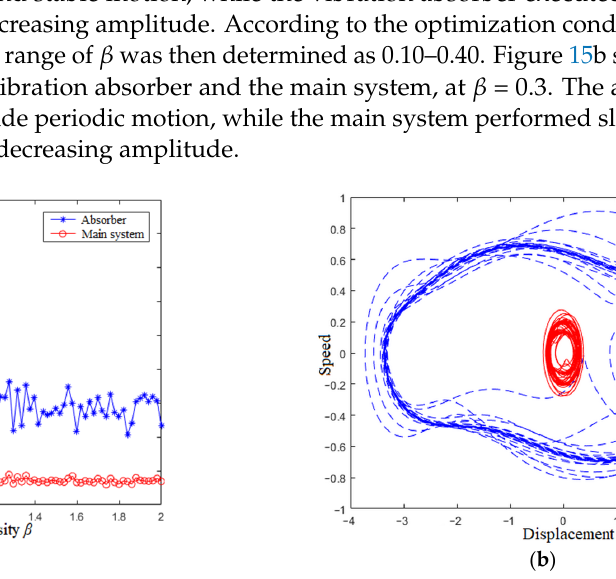
Figure 15. Response amplitude and phase diagram of two vibrators in the case of off-resonance ω = 0.6. ( a ) Response amplitude; ( b ) Phase diagram ( β =